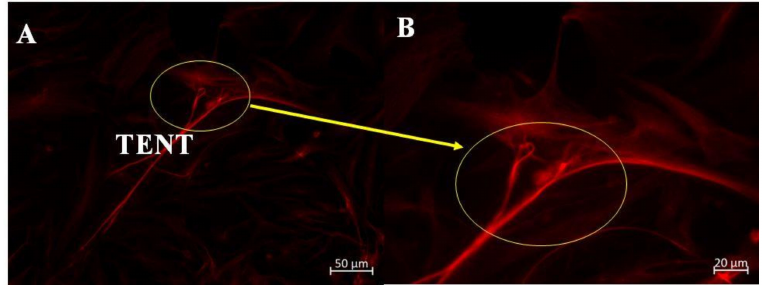
Figure 2. Alexa Fluor 568-stained α -tubulin of a non-treated bEnd3 cell. ( A ) α -tubulin interaction of cells, displaying the intramolecular profile of TENTs; ( B ) The magnification of the interaction of these α -tubulin-based TENT extending between the BECs membranes as indicated by the yellow circles.